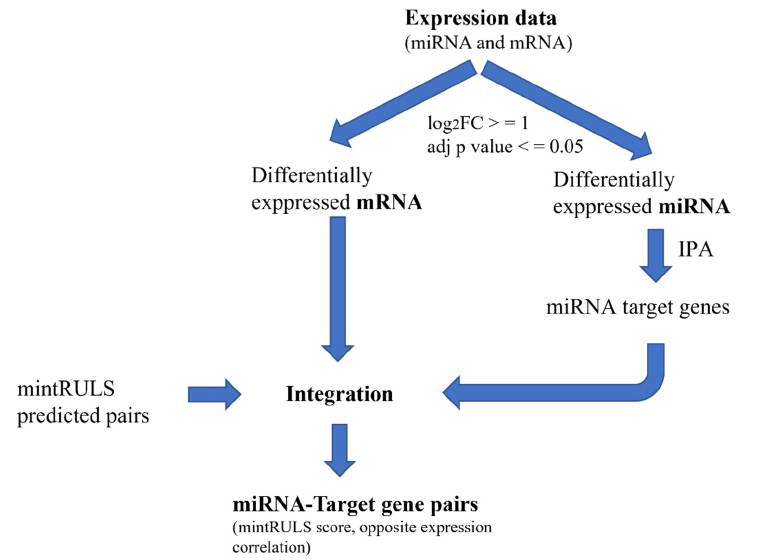
Figure A3. The workflow for integrating differentially expressed mRNAs and miRNA with the IPA results and mintRULS predictions. miRNA/gene expression analysis in control and septic mice